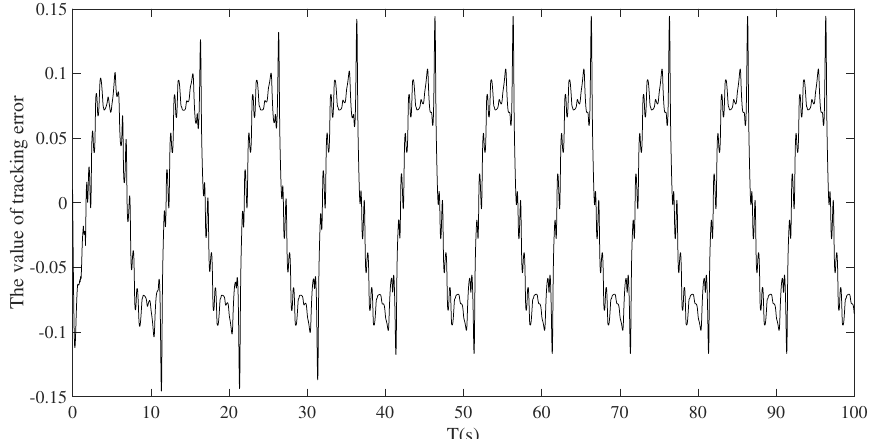
Figure 6. Tracking error curve in known time-varying delay form (without dead-zone compensation